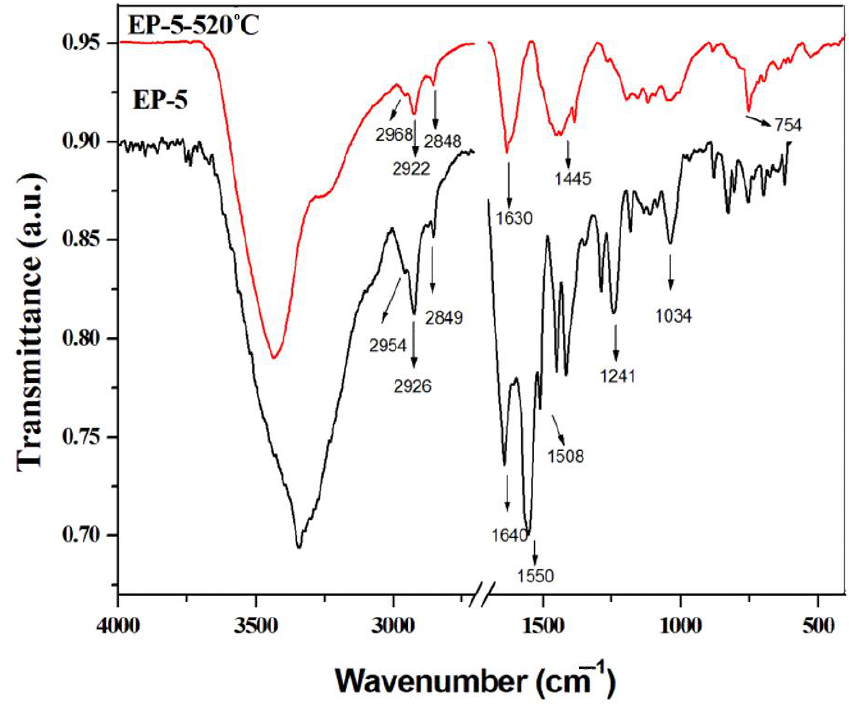
Figure 11. FTIR spectra of EP-5 and EP-5 heated up to 520 °C.